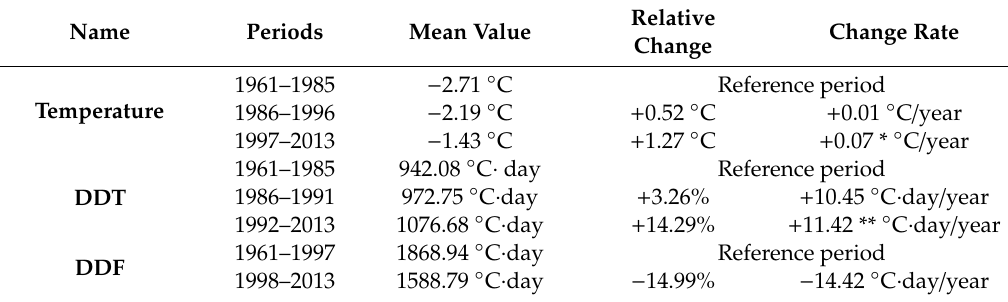
Table 5. Temperature and freezing–thawing indices changes in respective